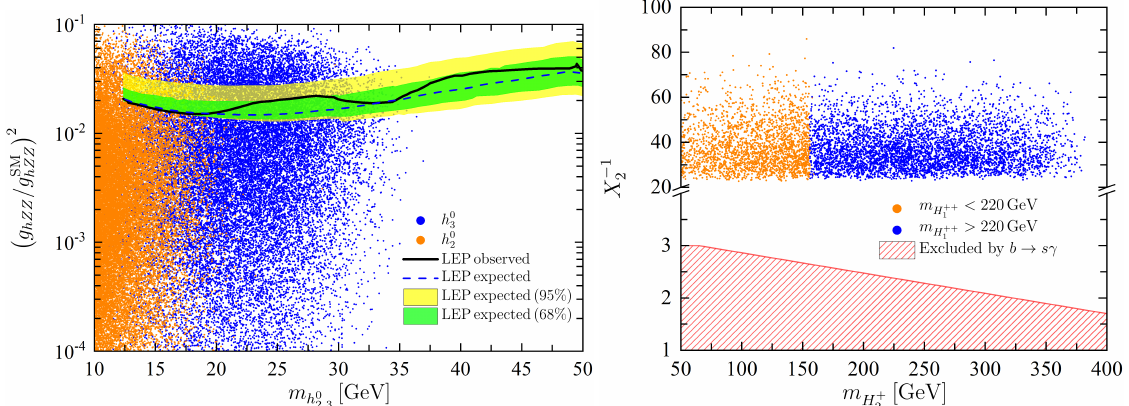
Figure 7. Allowed regions in the parameter space of the model discussed in [31], taken from that reference. For neutral and charged new scalars, masses (cid:46) 125GeV are